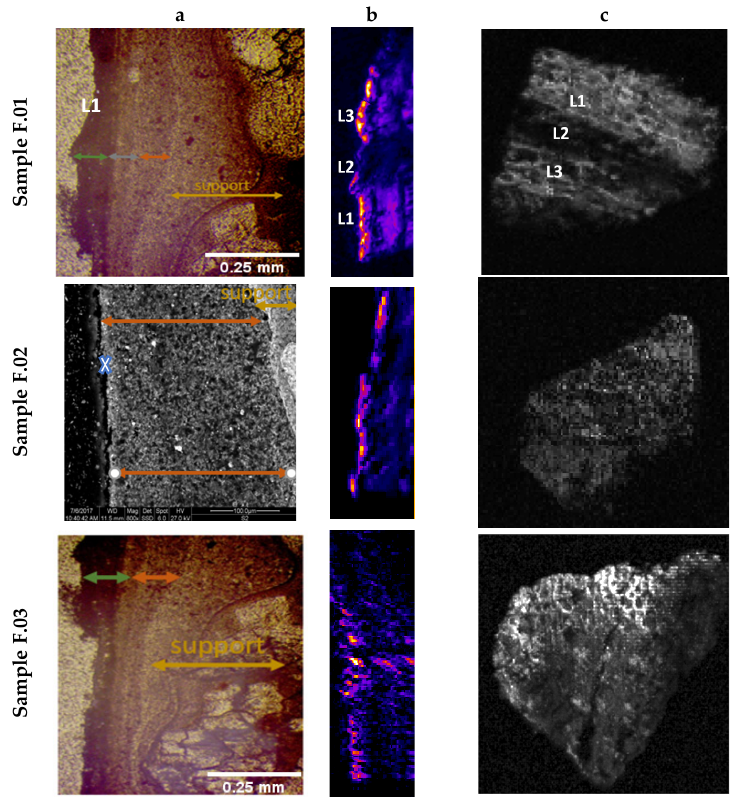
Figure 2. Moving from the left: ( a ) cross-section images; ( b ) cross-section imaging obtained with PA; ( c ) and relative PA later view